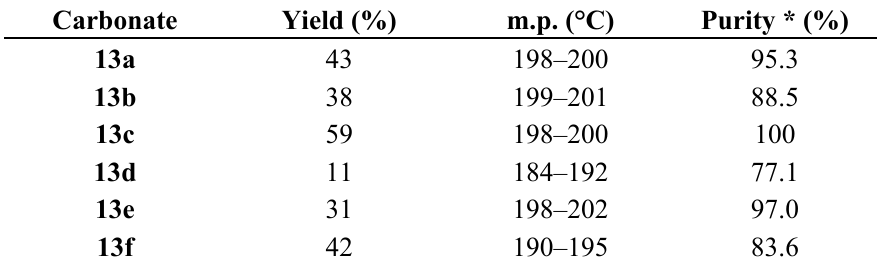
Table 3. Yield %, m.p., purity % of 4-(ethoxycarbonylamino)benzoic acid 21